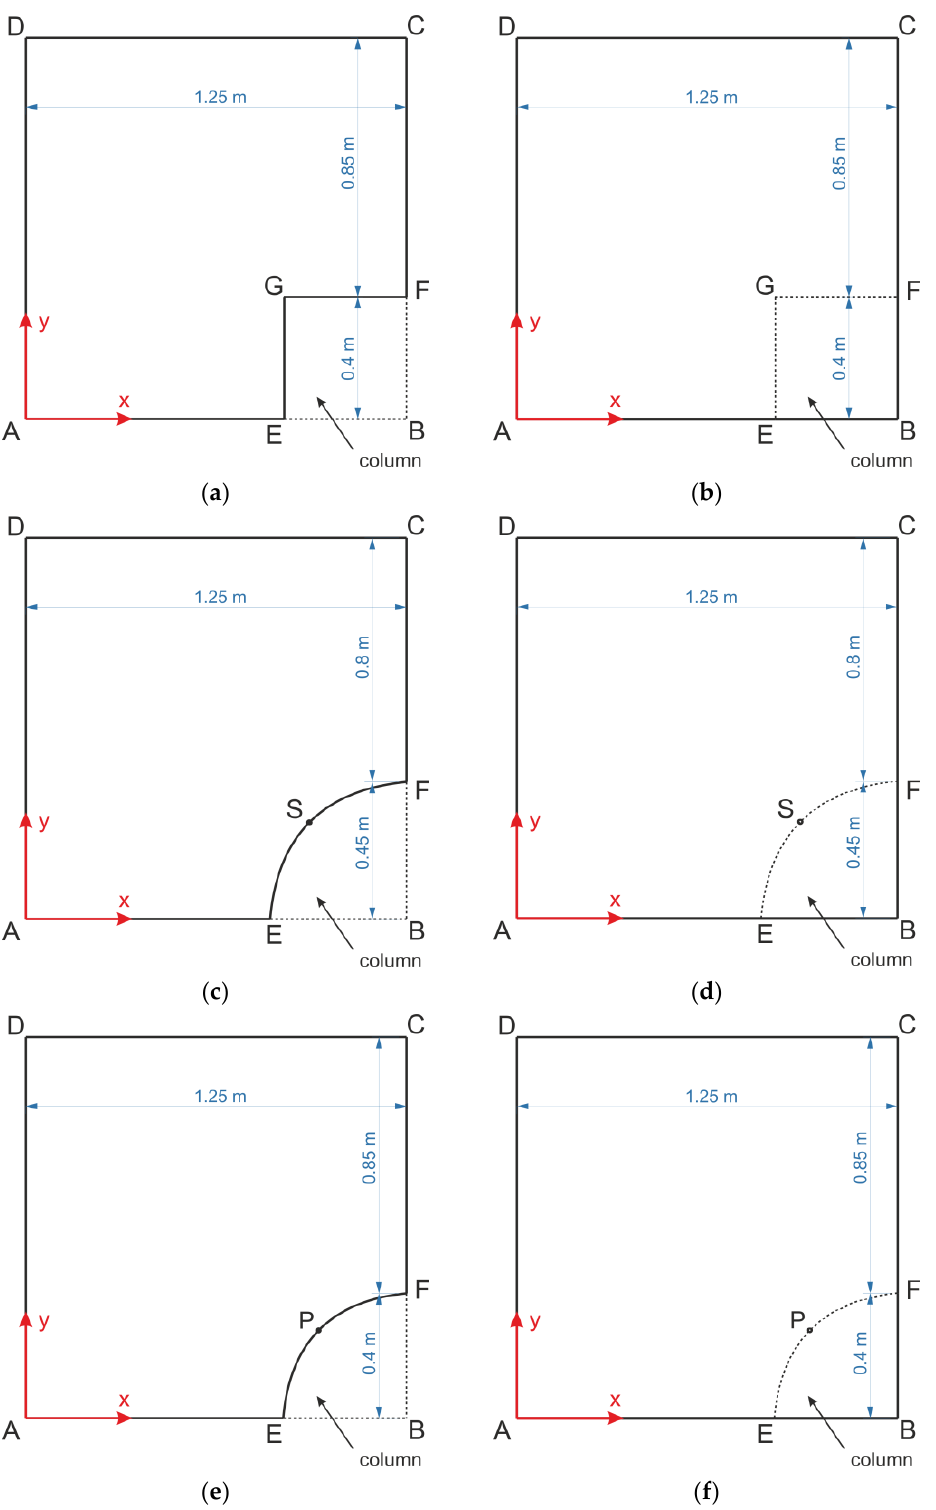
Figure 3. Geometric variants adopted in the FEM models of the reinforcement: ( a ) variant A1, ( b ) variant A2, ( c ) variant B1, ( d ) variant B2, ( e ) variant C1, ( f ) variant C2.